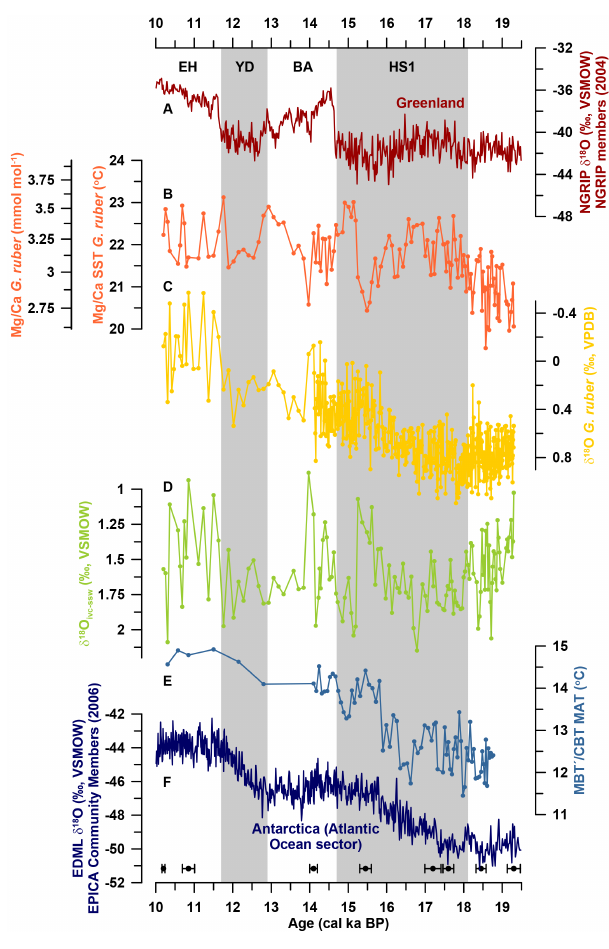
Figure 4. Proxy records for the western South Atlantic and south- eastern South America spanning Termination 1 based on marine sediment core GeoB6211-2 together with ice core temperature records. (a) North Greenland Ice Core Project (NGRIP members, 2004) δ 18 O plotted versus the Greenland Ice Core Chronology 2005 (GICC05) (Rasmussen et al., 2006). (b) GeoB6211-2 Glo- bigerinoides ruber (white) Mg / Ca and Mg / Ca-based sea surface temperatures. (c) GeoB6211-2 Globigerinoides ruber (white) sta- ble oxygen isotope ( δ 18 O) (partially from Chiessi et al., 2009). (d) GeoB6211-2 continental-ice-volume-corrected oxygen isotopic composition of surface sea water ( δ 18 O ivc-ssw ), a proxy for salinity. (e) GeoB6211-2 methylation of branched tetraether (MBT’)- and cyclization of branched tetraether (CBT)-based mean air tempera- ture (MAT). (f) EPICA Dronning Maud Land (EPICA Community Members, 2006) δ 18 O plotted versus its original chronology. Black symbols at the bottom of the panel depict calibrated radiocarbon ages used to produce the age model for GeoB6211-2. Grey vertical bars depict Heinrich Stadial 1 (HS1) (Sarnthein et al., 2001) and the Younger Dryas (YD) (Rasmussen et al., 2006). BA: Bølling– Allerød; EH: early